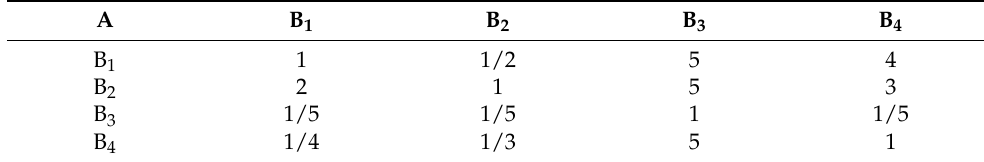
Table 4. Mutual factor weights of the rule layer B.